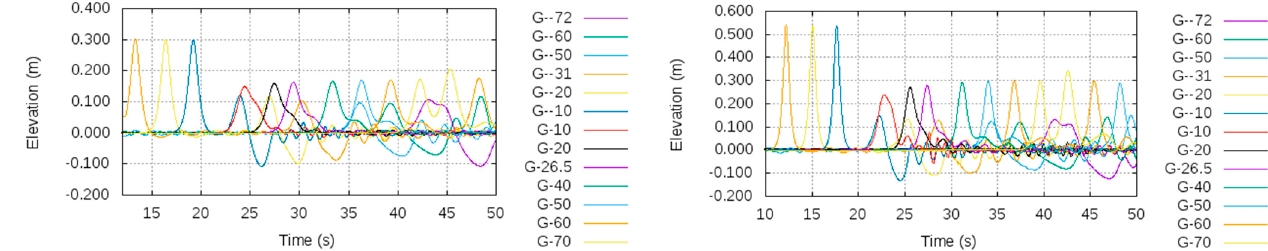
Figure 21. Free surface elevations measured by different wave gauges along the simulation domain for a/h = 0.3 and 0.5 versus time t (s) using OpenFOAM.